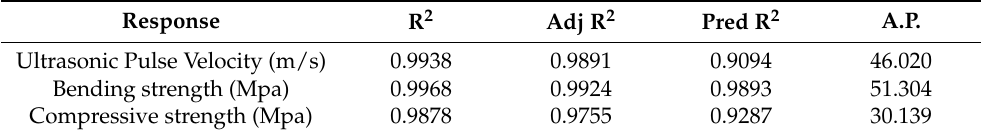
Table 6. Coefficient of determinations for response